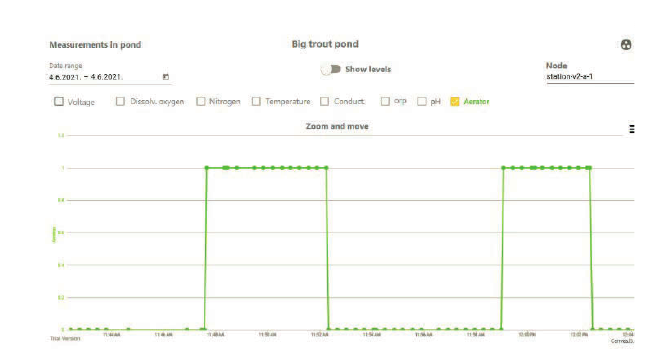
Fig. 10. The operation time of the aerator.